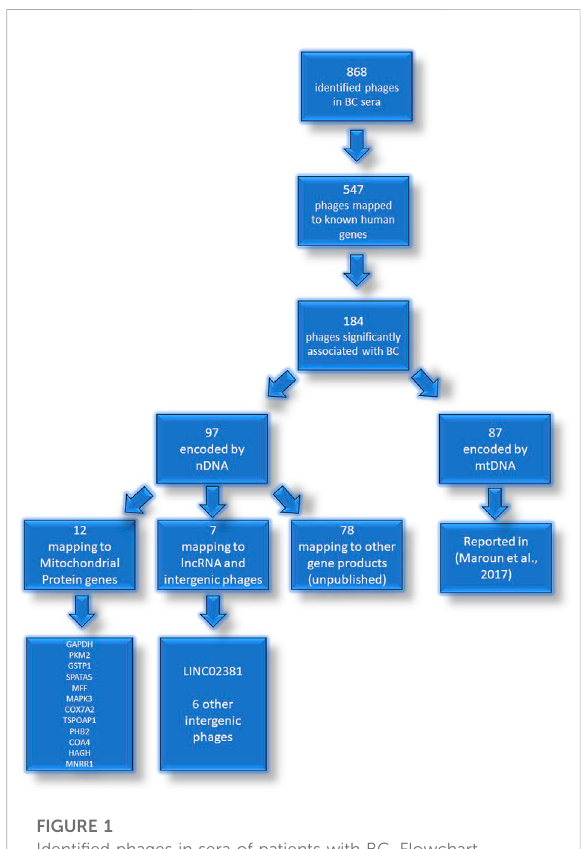
FIGURE 1 Identi fi ed phages in sera of patients with BC. Flowchart representation of the experimental identi fi cation of autoantibody targets in BC patients. The mtDNA genes targeted by autoantibodiesinBC werereported previously (Maroun etal.,